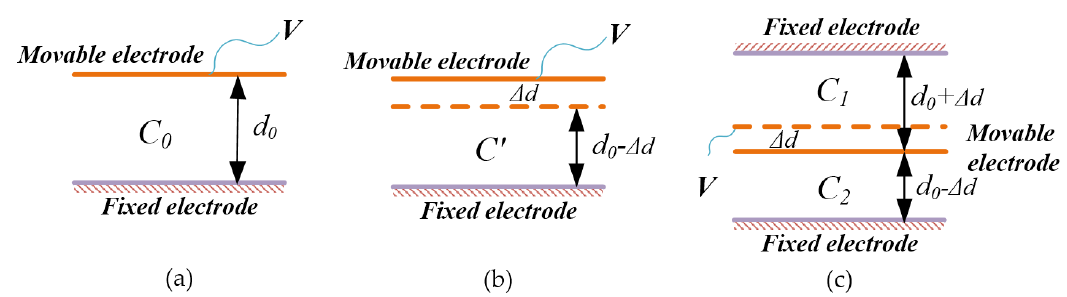
Figure 2. Schematic structures of variable capacitances ( a ) Single capacitor; ( b ) The gap change for single capacitor; ( c ) The gap change for differential capacitor.